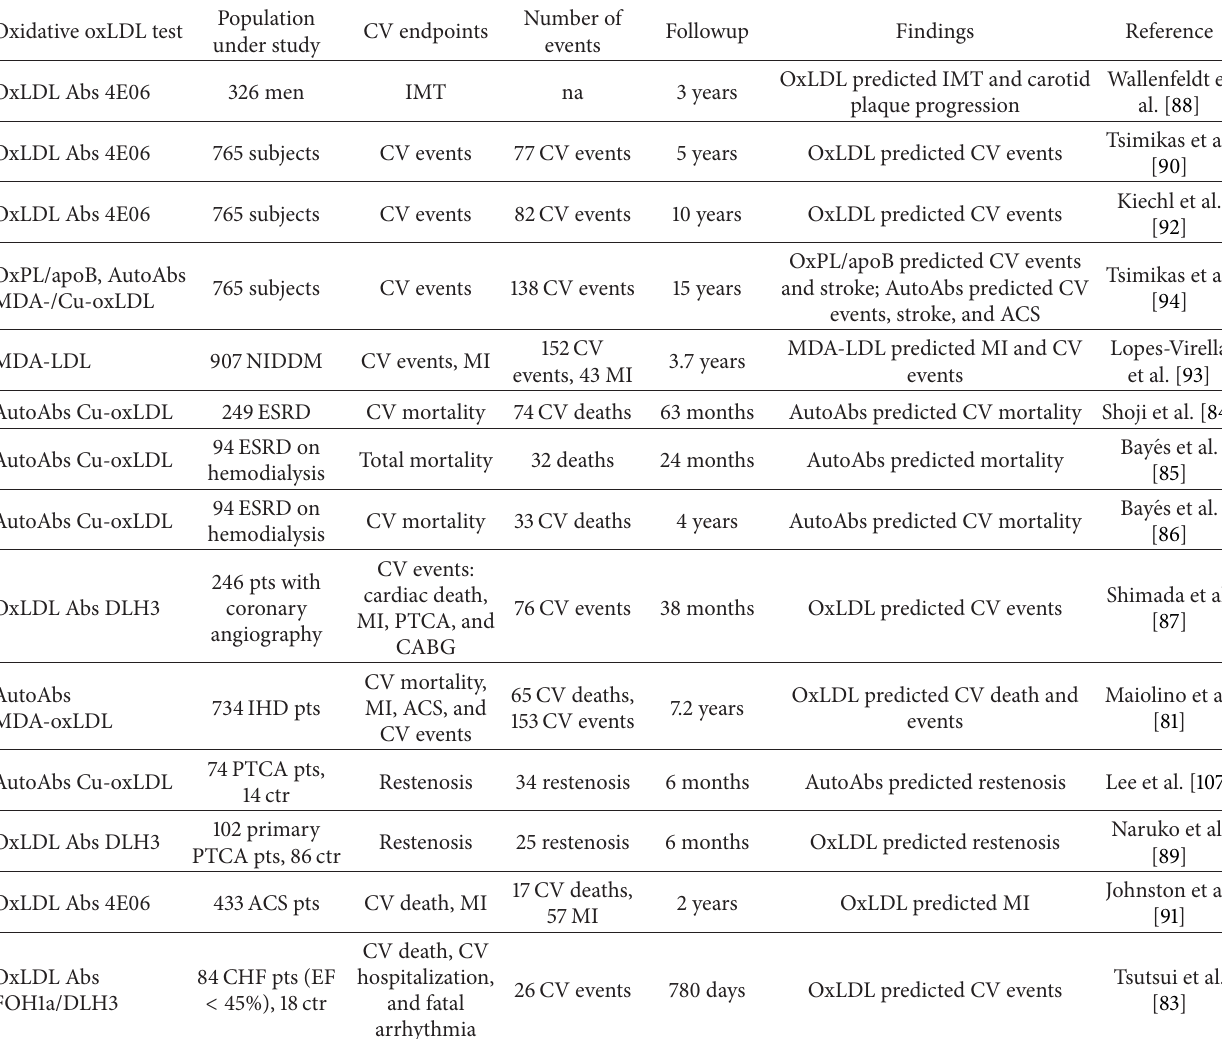
Table 1: Cohort studies demonstrating an association between oxidized low-density lipoprotein measurement and cardiovascular events. Oxidative oxLDL